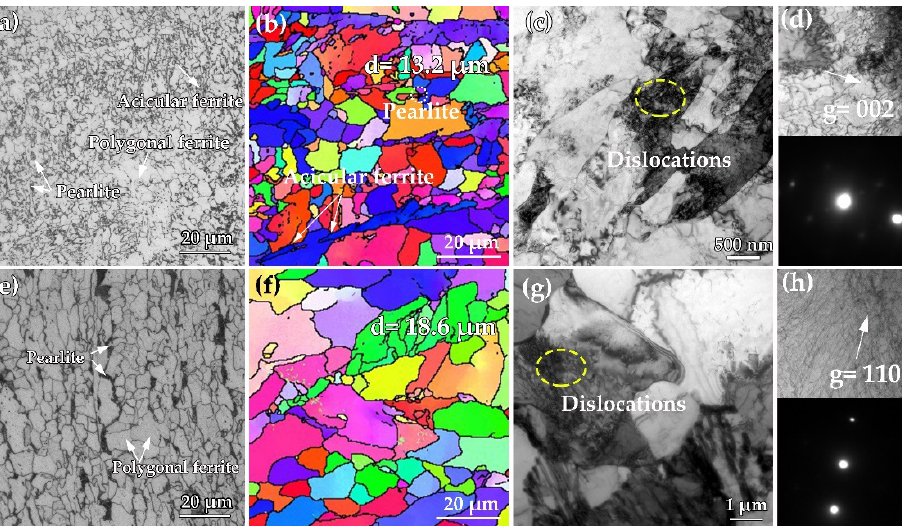
Figure 3. Microstructure analysis of the specimens obtained from the surface and mid-thickness region of steel B. ( a , e ) OM images; ( b , f ) EBSD micrographs; ( c , g ) TEM images; ( d , h ) the enlargement view of yellow circle in ( c , g ) showing the dislocations observed by two-beam diffraction methods in different vectors.